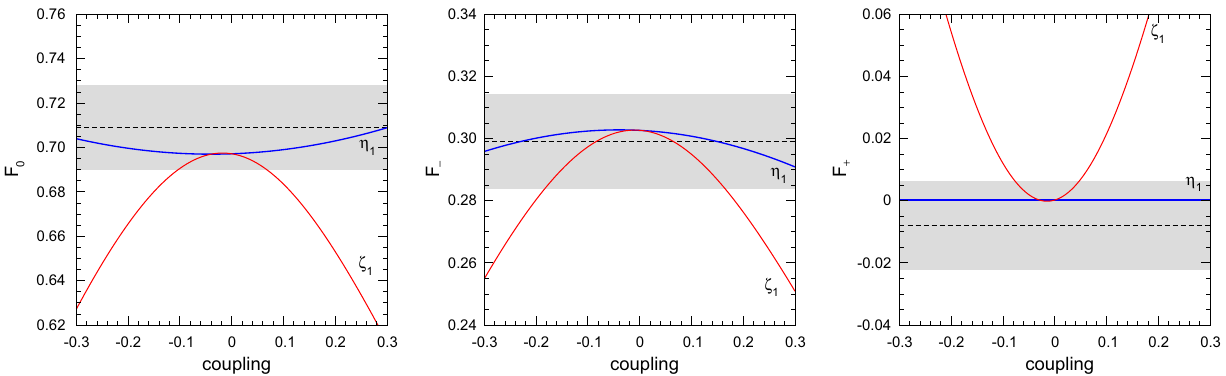
Fig. 1 Dependence of the helicity fractions on the parameters η 1 and ζ 1 defined in Eq. (25). The dashed lines and shaded band represent the current most precise measurements [6] and their uncertainty